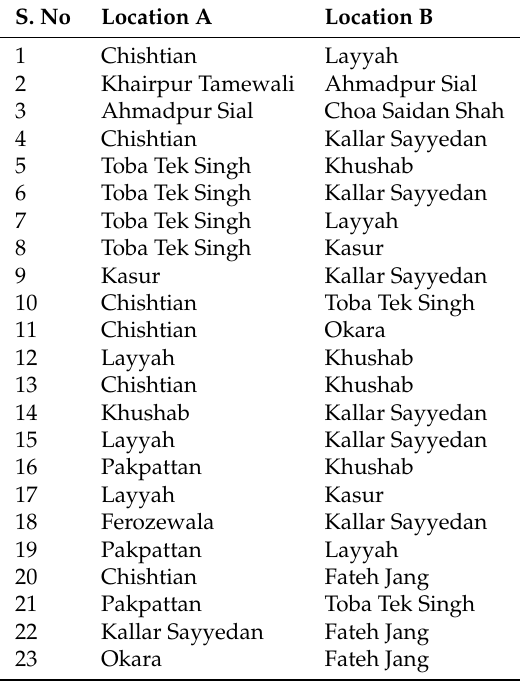
Figure 9. Hotspot relation mining based on features and incidence rate. Width of the line shows similar to different areas. Graph shows location pair connected for: ( a ) Very similar hotspots. ( b ) Similar hotspots. ( c ) Weak similar hotspots. ( d ) Different hotspots. Table 3. Location pairs with very similar conditions identified scaled to the tehsil